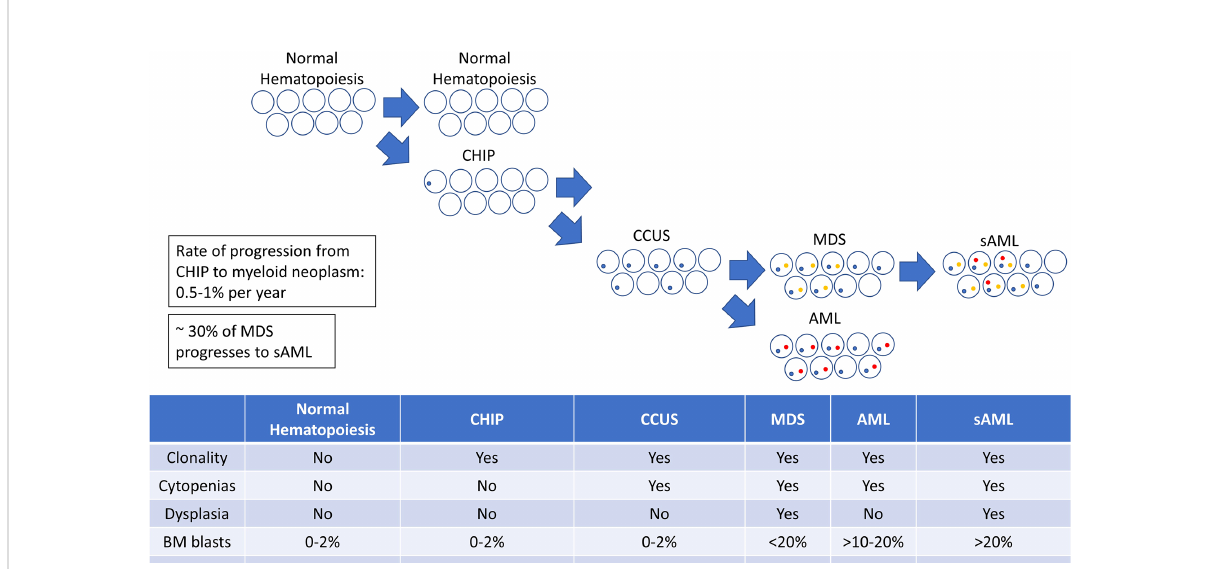
FIGURE 1 A diagram illustrating the progression from clonal hematopoiesis to MDS, AML, and